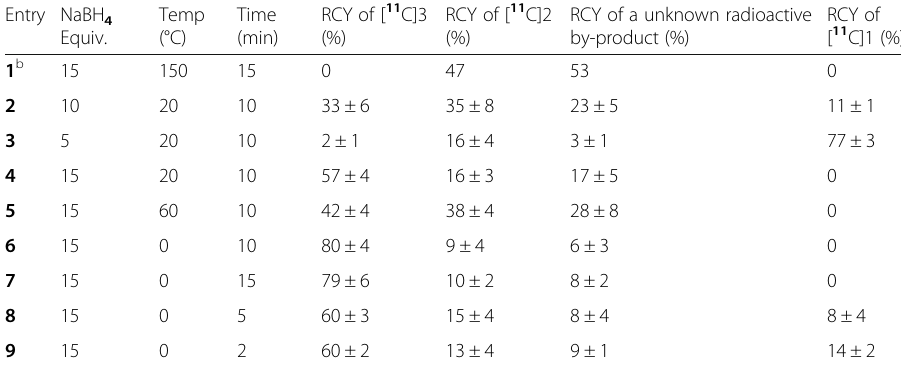
Table 1 Reduction of [ 11 C] benzyl isocyanate to [ 11 C] benzylformamide ([ 11 C] 1 ) a Entry NaBH 4